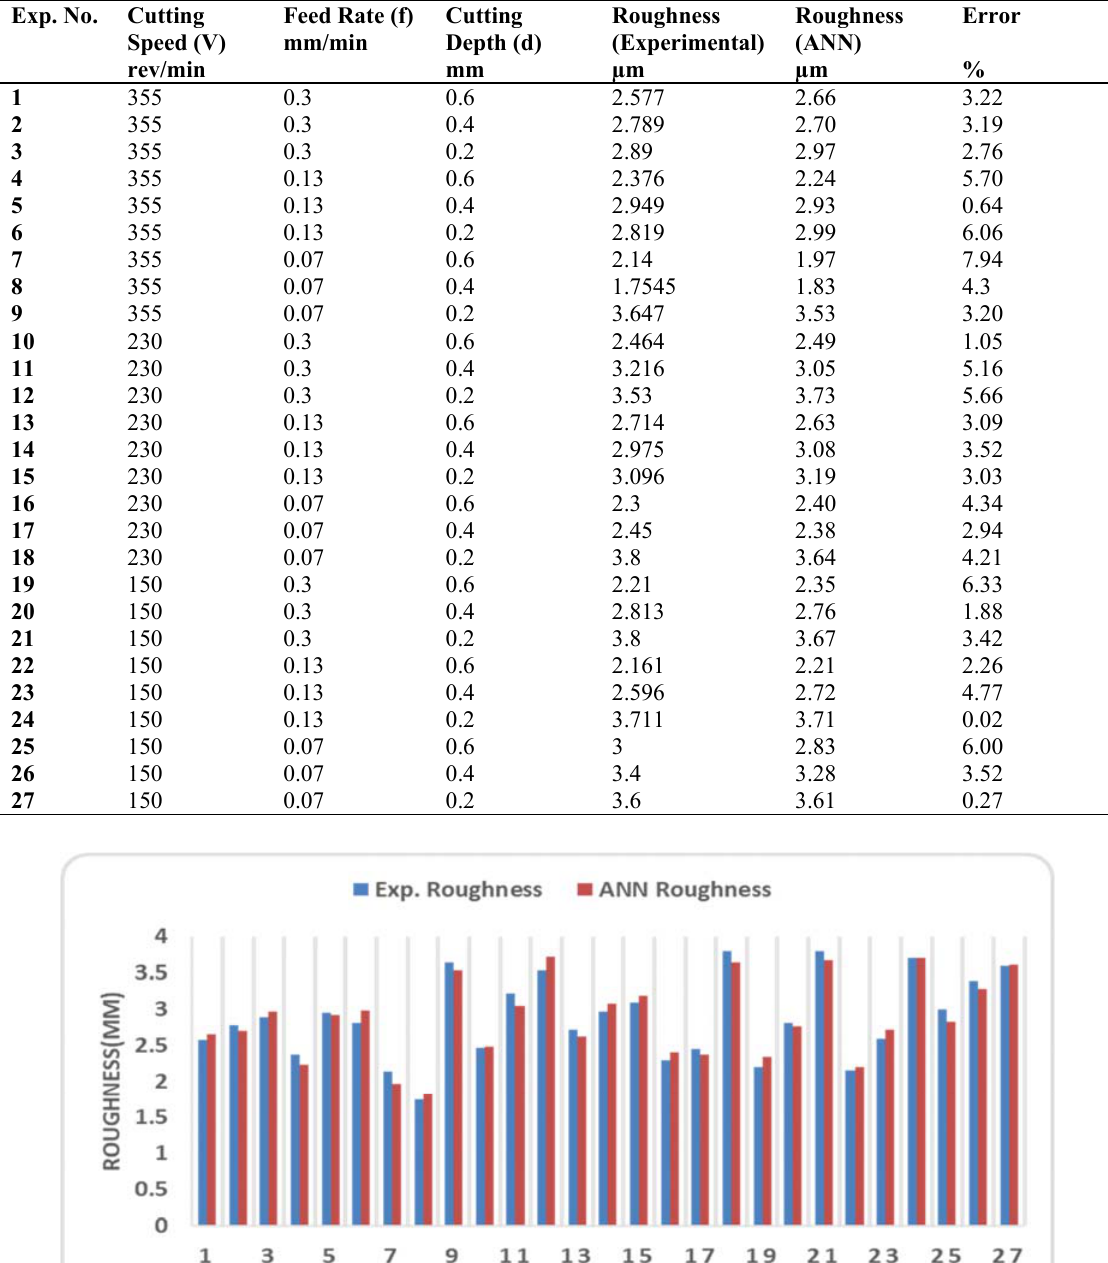
Table 3, Experimental and estimated surface roughness comparison Exp. No.